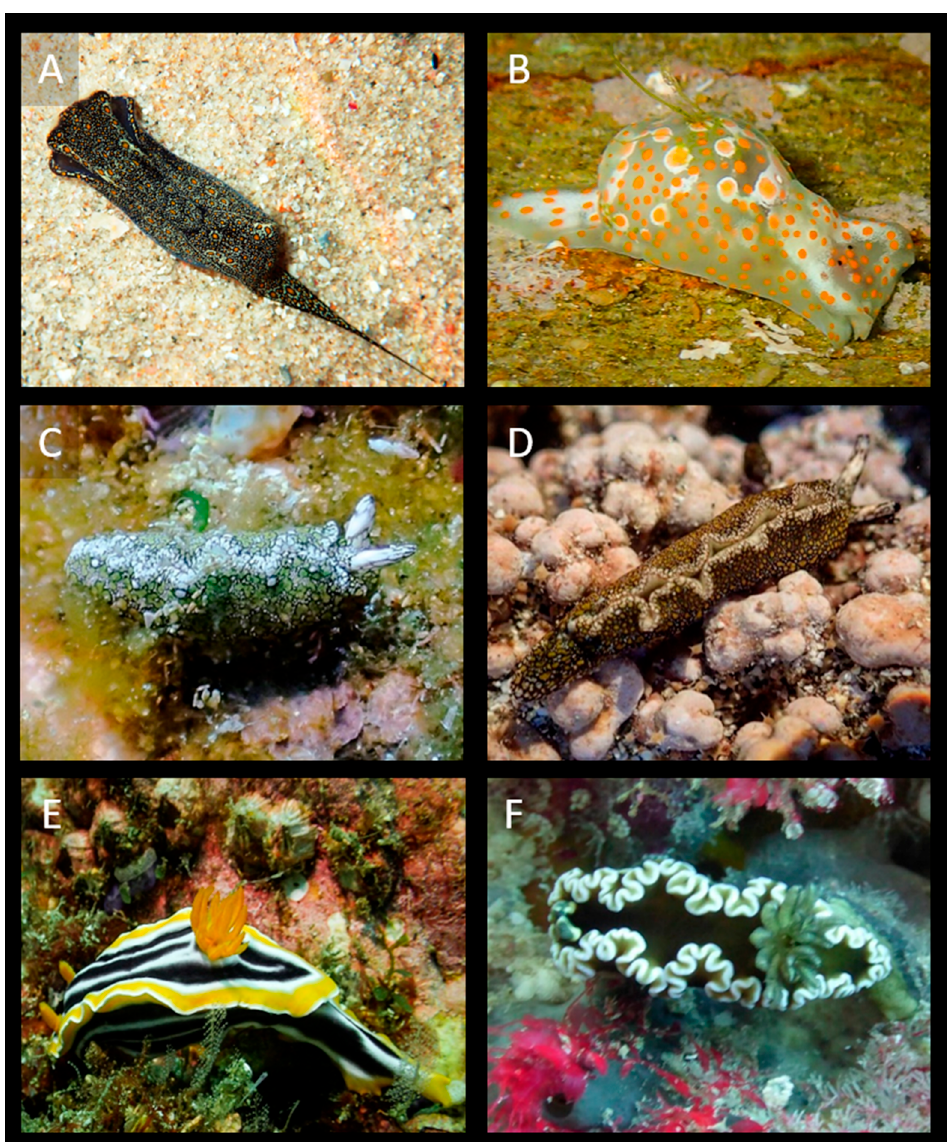
Figure 2. ( A ) Mariaglaja tsurugensis , Angourie Pool, NSW, 21 September 2017. Photo: S.D.A. Smith. ( B ) Haminoea cymbalum at Blue Pool, Bermagui, NSW on 10 March 2017. Photo: N. Shaw. ( C ) First Australian observation of Elysia sp. at North Solitary Island, NSW, 27 May 2017 Photo: M. Nimbs. ( D ) Thuridilla flavomaculata at Lord Howe Island, NSW, 28 May 2017. Photo: K. May. ( E ) Chromodoris magnifica at North Solitary Island, NSW, 18 May 2017. Photo: M. Nimbs. ( F ) Southernmost record of 2017. Photo: J. Freya.